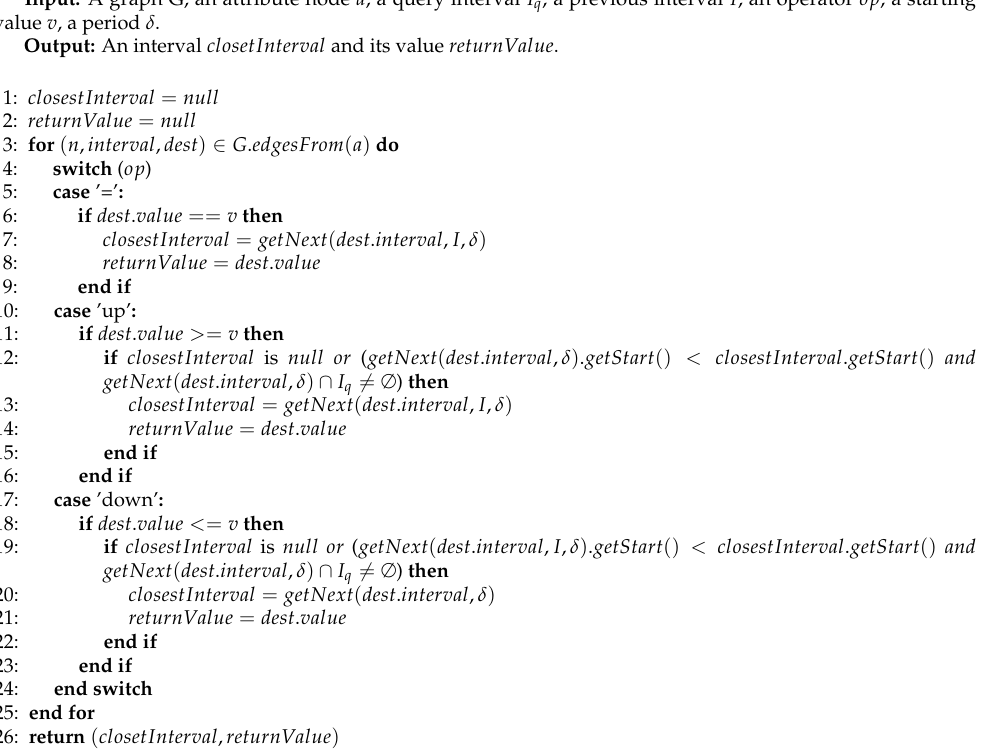
Algorithm 2 getInterval : Obtains the interval of a sensor node according to an